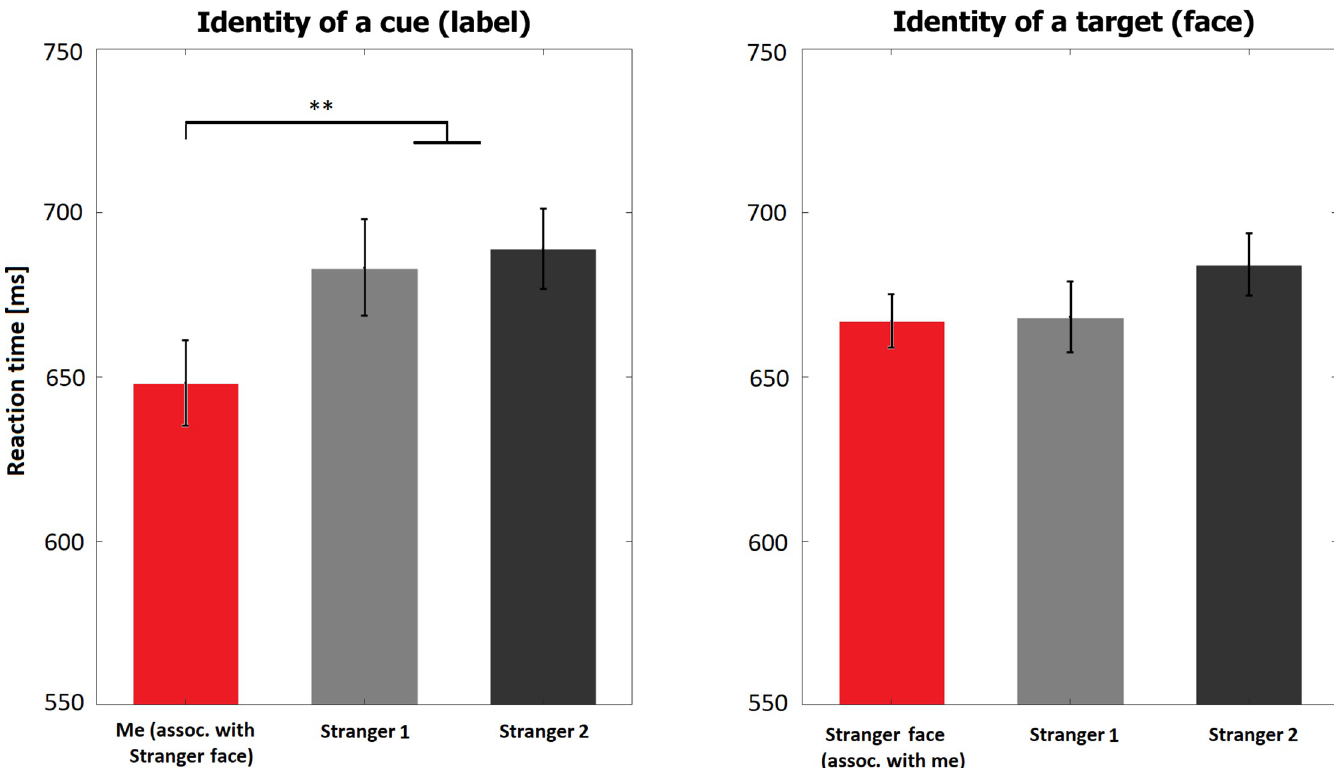
Fig 2. Results of Experiment 1. Red bar represents average reaction time for self-related condition, and grey bars for stranger-related conditions. � reflects statistical significance below 0.05, and �� below 0.01.